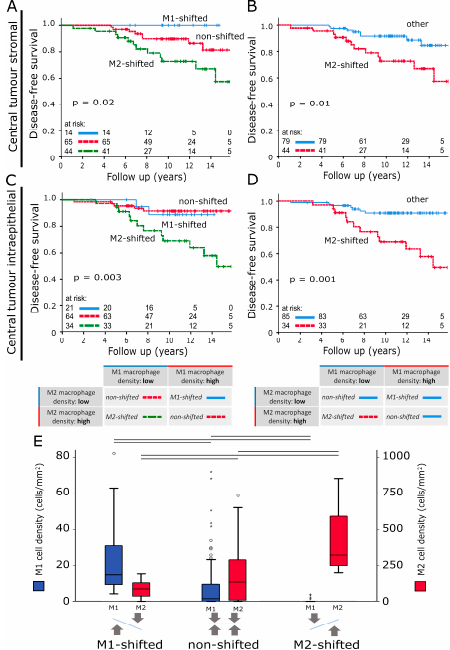
Figure 3. ( A , C ) Disease-free survival analysed with the Kaplan–Meier method and log-rank test according to TAM polarisation shift classifications based on stromal and intraepithelial macrophage densities in central tumour samples. ( B , D ) Versions of ( A ) and ( C ) that compare disease-free survival of the M2-shifted group to the remaining two groups. The tables below the survival plots give a detailed explanation of group compositions. ( E ) Intraepithelial macrophage density distributions in invasive front samples according to the TAM polarisation shift classification. The scale on the left indicates M1 macrophage densities (blue) while M2 cell densities can be found on the right (red). The central line represents median values while the box is indicative of the interquartile range (IQR). Whiskers represent 1.5 × IQR or minimum / maximum. Outliers are indicated by points (up to 3 × IQR) or asterisks ( > 3 IQR). Black bars signify p < 0.05 in Student’s t